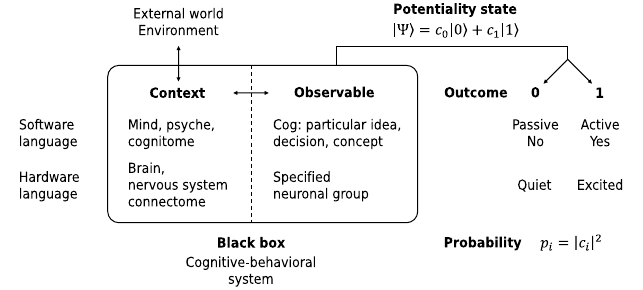
Figure 1. Quantum scheme of neuro-cognitive modeling. Cognitive and physiological terminologies reflect quantum-theoretic concepts (bold) in parallel way. In quantum approach, a cognitive-behavioral system is considered as a black box in relation to a potential alternative 0/1. Department of the black box responsible for the resolution of this alternative is observable, delineated from the context analogous to the Heienberg’s cut between the system and the apparatus in quantum physics. Relative to the dichotomic alternative 0/1, potential outcomes of the experiment are encoded by superposition vector state the system transfers to one of the superposed potential outcomes according to probabilities p i